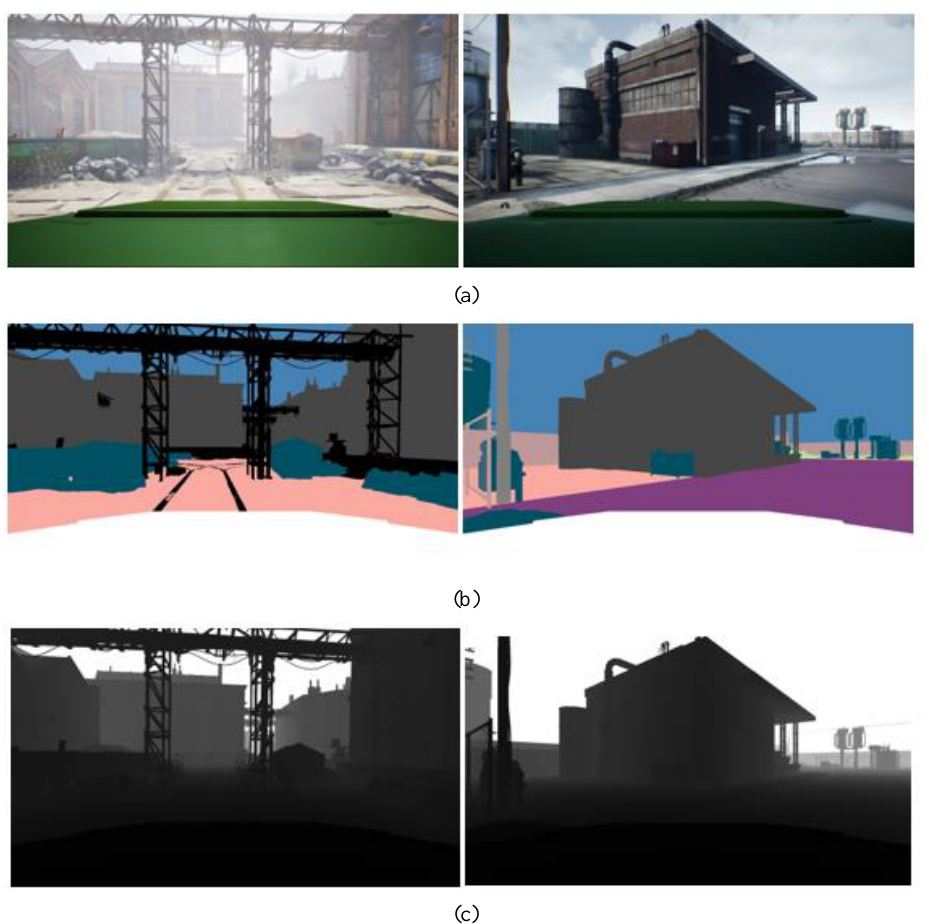
Figure 9. Input images from our datasets (a), semantic segmentation masks (b), depth mask (c).